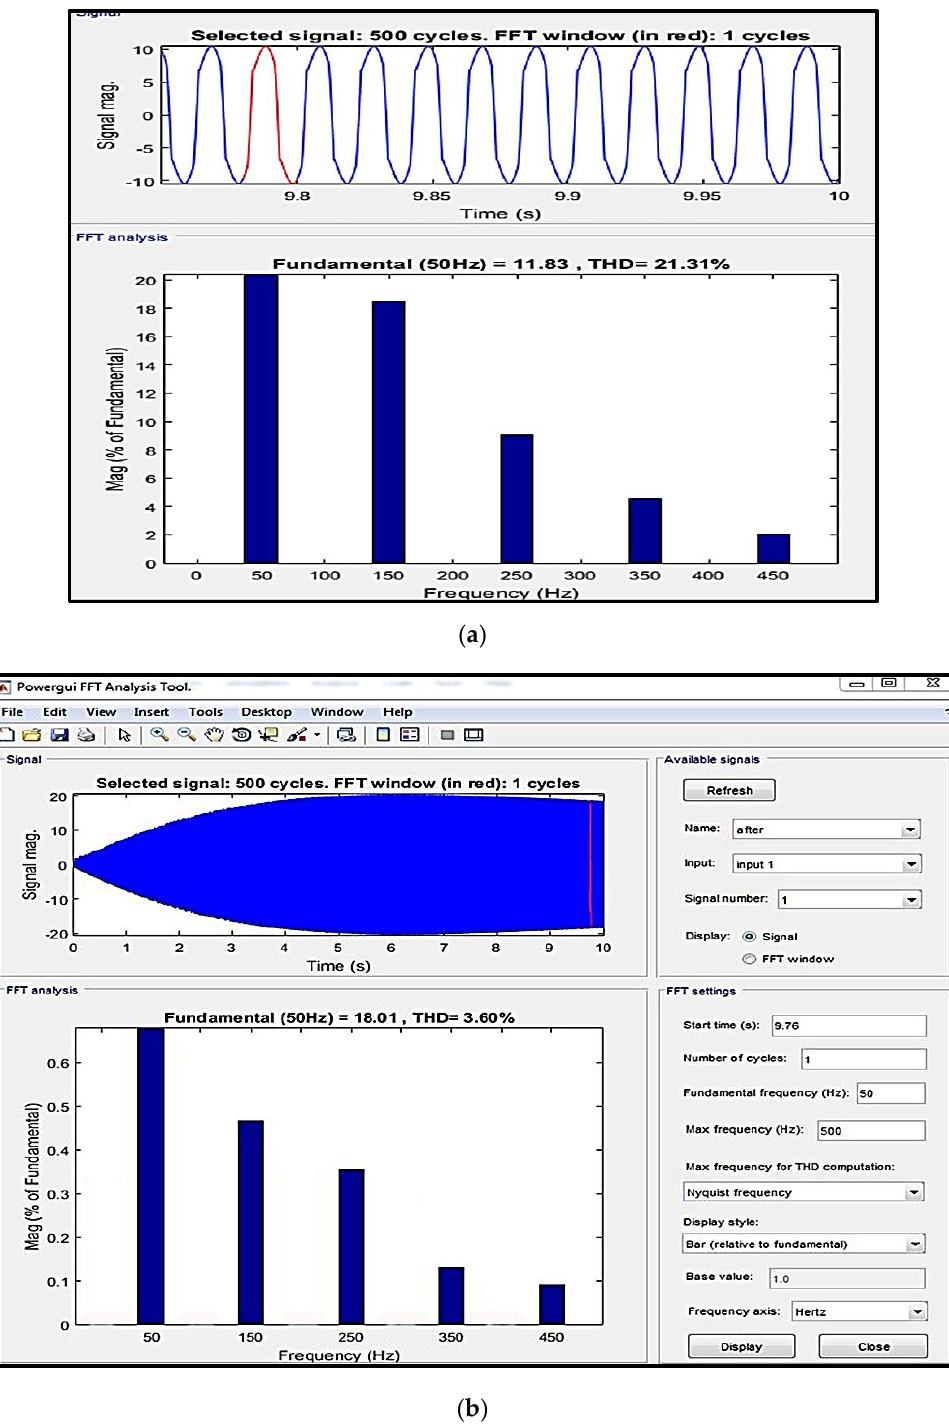
Figure 13. Harmonic analysis of single-phase SAPF by FFT in MATLAB/ Simulink environment ( a ) before compensation; ( b ) after compensation.